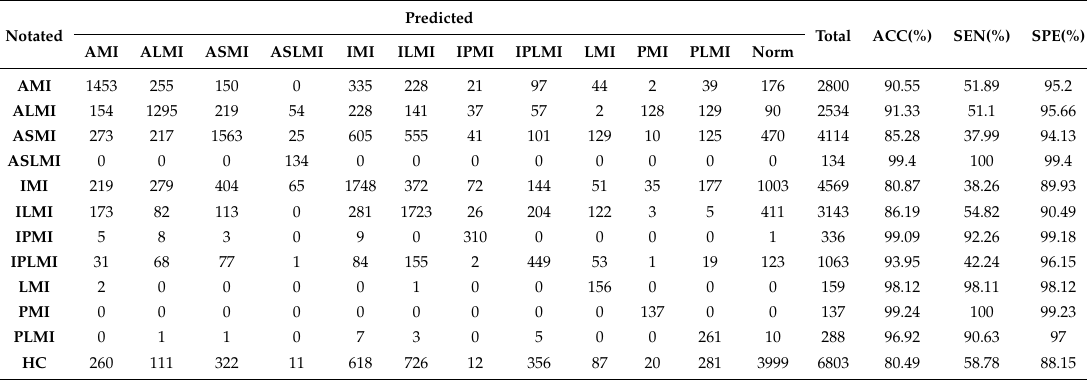
Table 5. Confusion matrix for MI classification using measured lead I ECG.